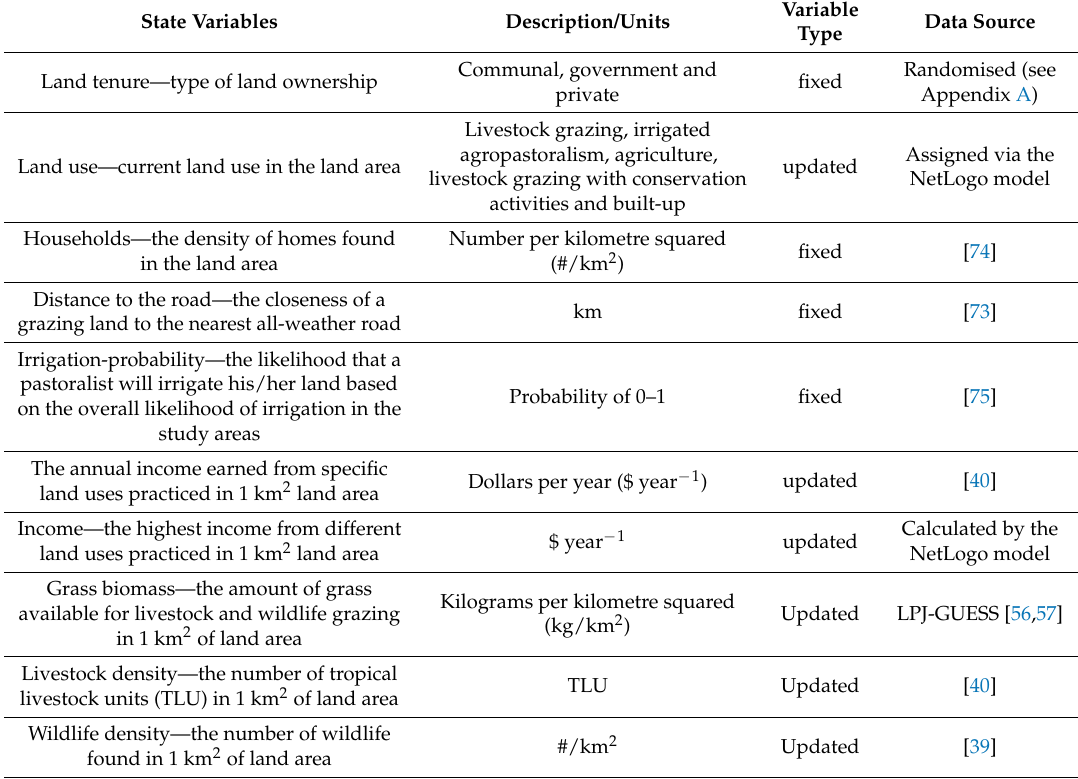
Table 1. Model variables, their descriptions and data sources. Variables are divided into two types: fixed variables are constant throughout the model run, while updated variables are continually altered throughout the model based on other